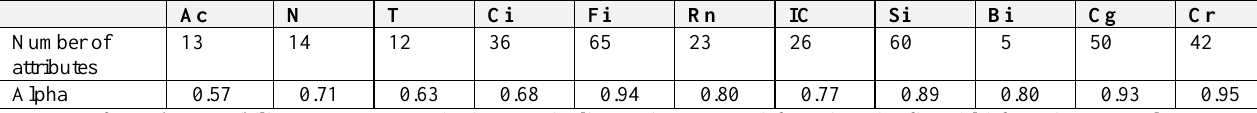
Table 3: Cronbach’s alpha per measurement instrument category Ac N T Ci Fi